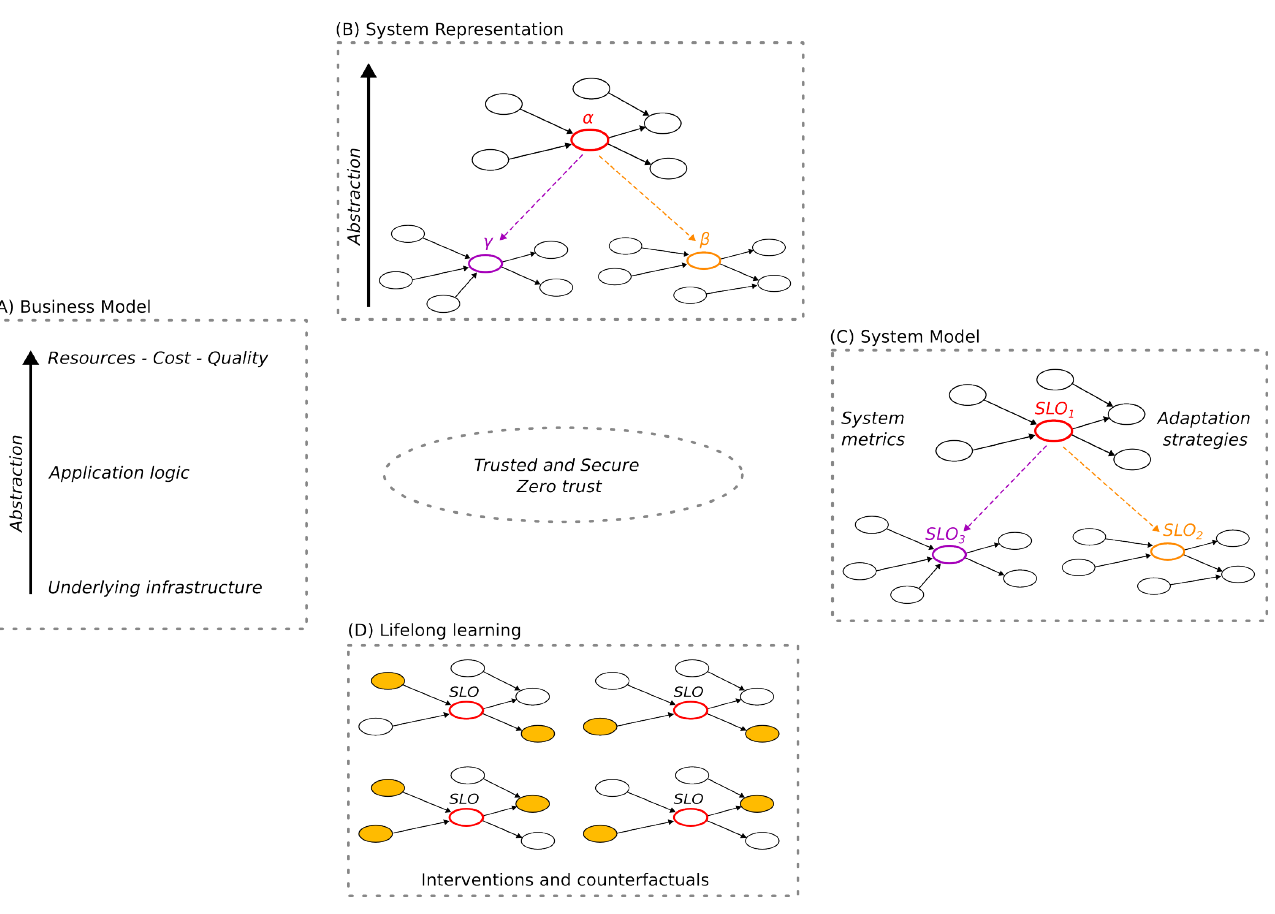
Figure 1. Starting at the center of the figure, we see that all developments require a trusted and secure environment, where Zero Trust techniques will have great relevance due to the heterogeneity and distribution characteristics of the system. On the left ( A ), three different abstractions for a Distributed Computing Continuum System are depicted (the granularity shown can be refined by showing network characteristics or unfolding aspects from the application logic). Each abstraction can easily engage a kind of stakeholder. However, the highest level: Resources-Cost-Quality, aims at being understood by all of them. On top ( B ), there is the representation of the system through Markov Blankets, considering α as a high-level abstraction variable that we can assess by observing the surrounding node, i.e., those factors that affect its value, remarkably thanks to the Markov Blanket approach only those that are relevant are there. Further, α can be decomposed on other lower-level variables ( β and γ ), providing a nested structure that can cover the entire system. On the right ( C ), we take advantage of this representation to embed SLOs, more specifically, a DeepSLO, in order to model the behavior of the system. As an example, SLO 1 can be related to the quality of a machine-learning inference component, which has its own metrics and adaptation strategies. This is linked to two other lower-level SLOs; in this example, SLO 2 can control the input data by making sure that it has the expected resolution, while SLO 3 controls the required time to perform the inference. Having this decomposition enables a fine-grained capacity for adaptation; other lower-level or higher-level SLOs could be developed if needed to have a broader view of a larger component or a more fine- grained control over a smaller one. On the bottom ( D ), several cases are shown with forced values for metrics and/or elastic strategies. This way, causal inference can improve the systems model to deal with future situations that are not yet known, providing a basis to deal with unexpected or unforeseen